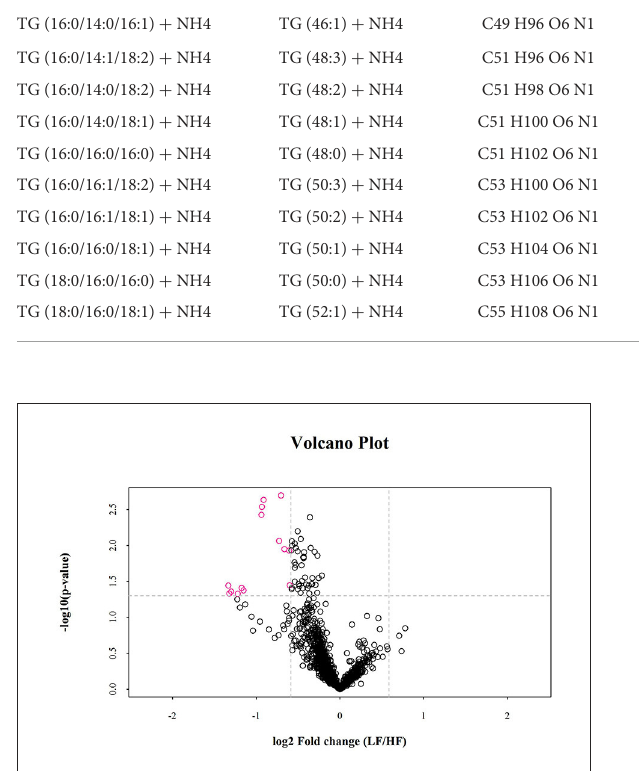
FIGURE6 Volcano plots for the distribution of significantly differences in lipid molecules. The rosy dots are significantly differential lipid molecules screened for univariate statistical